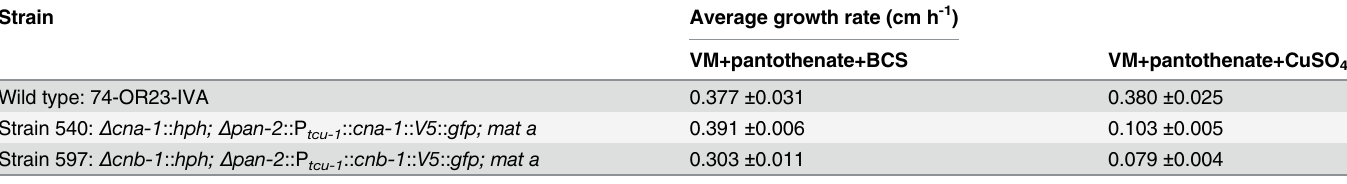
Table 3. Average growth rate. Strain Average growth rate (cm h -1 )